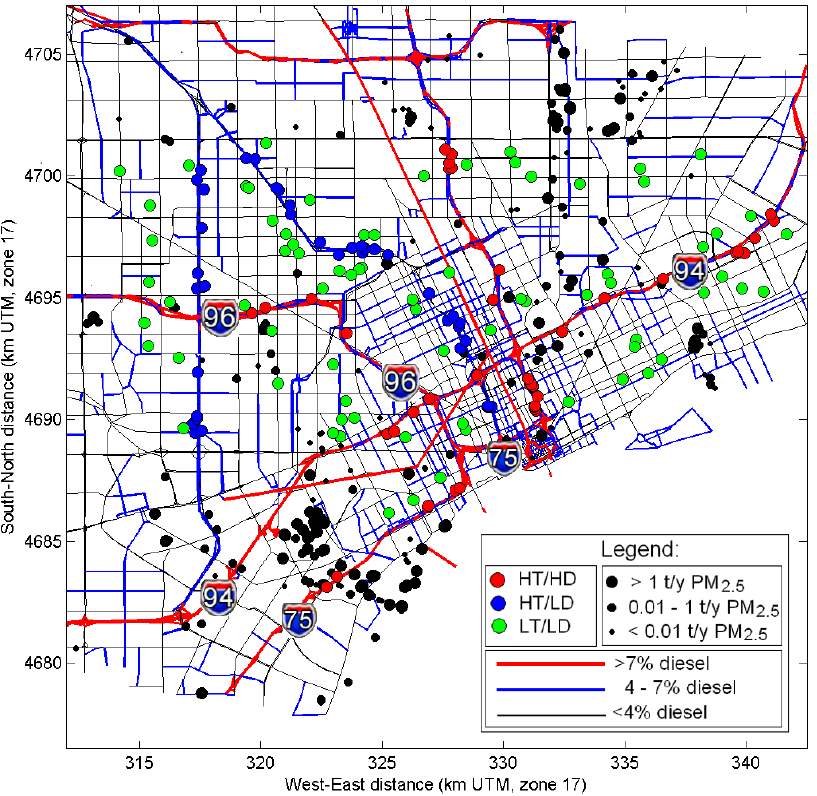
Figure 1. Modeling domain for the NEXUS study. Major highways are shown as red and blue lines (for >7% diesel and 4%–7% diesel fraction) and other roads–as black lines. Model receptors are shown in red, blue and green circles for the HD, LD and LT traffic exposure group, respectively. Stationary sources are shown as black dots (symbol size indicates the magnitude of PM annual 2.5